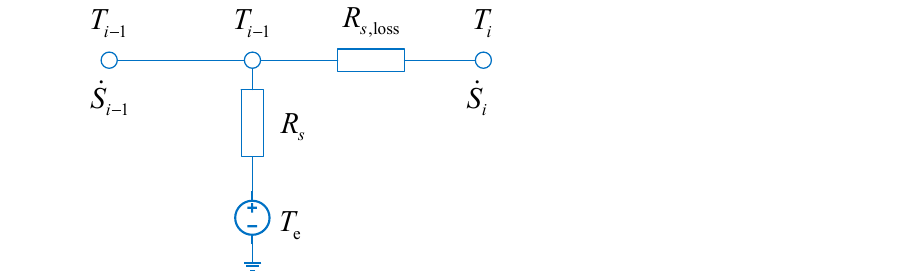
Figure 5. Convective equivalent model of entropy transport under steady state.